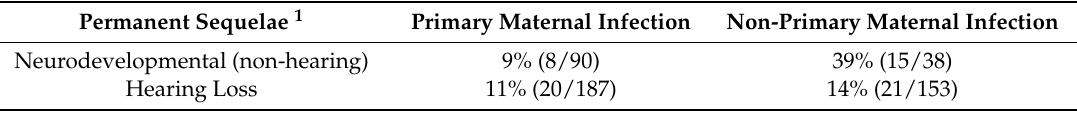
Table 1. Maternal immune status and long-term outcome of cCMV